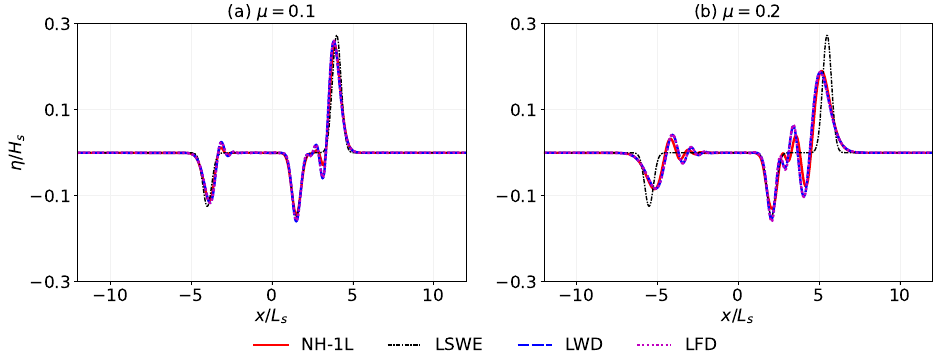
(cid:112) g / L s = 12 resulting from the NH-1L simulation